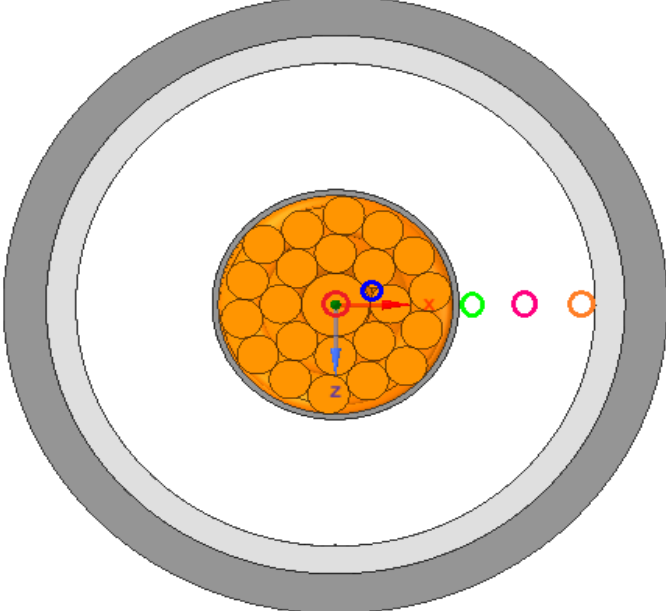
Figure 9. Color scheme for placement of